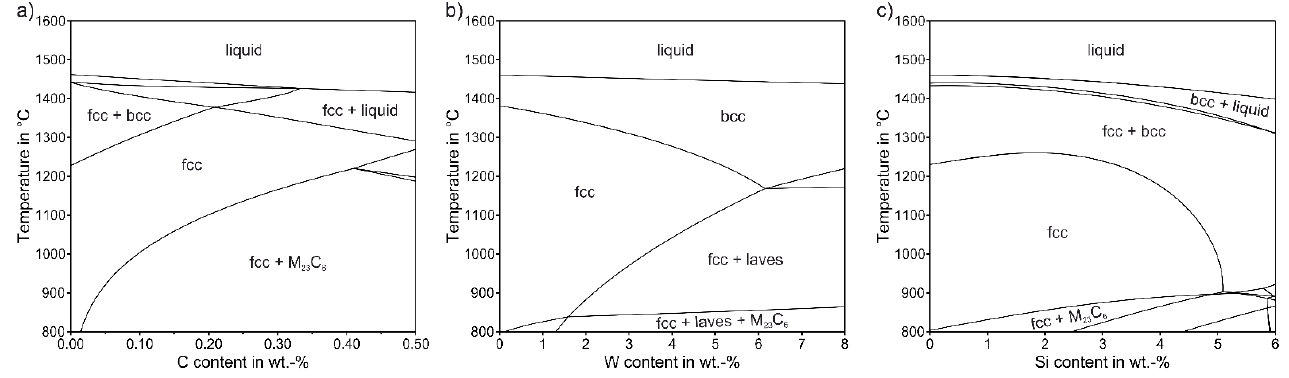
Figure 1. Thermodynamically calculated phase diagrams of the steels: ( a ) X2CrNi18 ‐ 9, ( b ) X2CrNiW15 ‐ 9 ‐ 5, and ( c ) X2CrNiSi18 ‐ 9 ‐ 4 (Thermo ‐ Calc 2020b, TCFe10